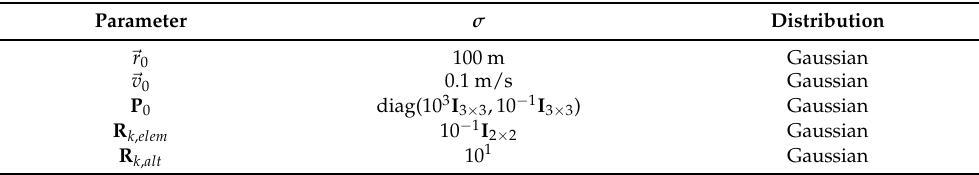
Table 2. Monte Carlo variables distribution assumptions around nominal values. For the matrices, each component is perturbed with the same random distribution.